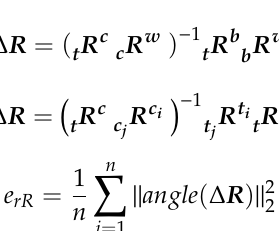
Figure 6. Probability distributions functions; ( a ) the measured position error from the robotic arm; ( b ) the modeled orientation error for the robotic arm.